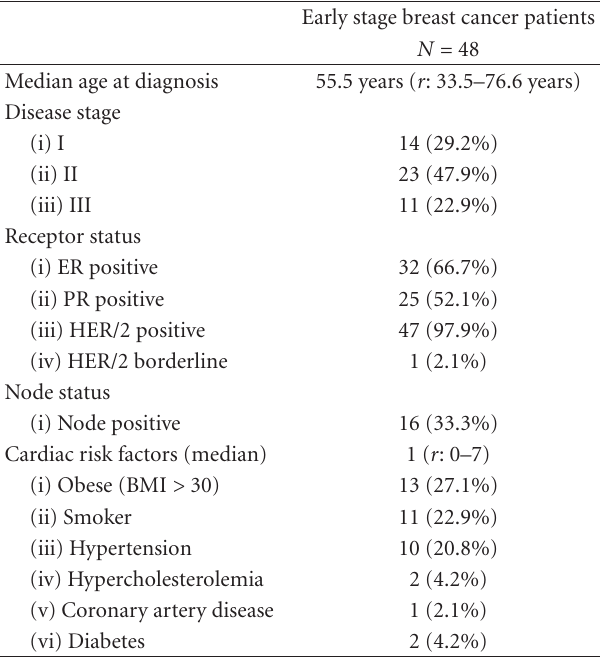
Table 1: Patient